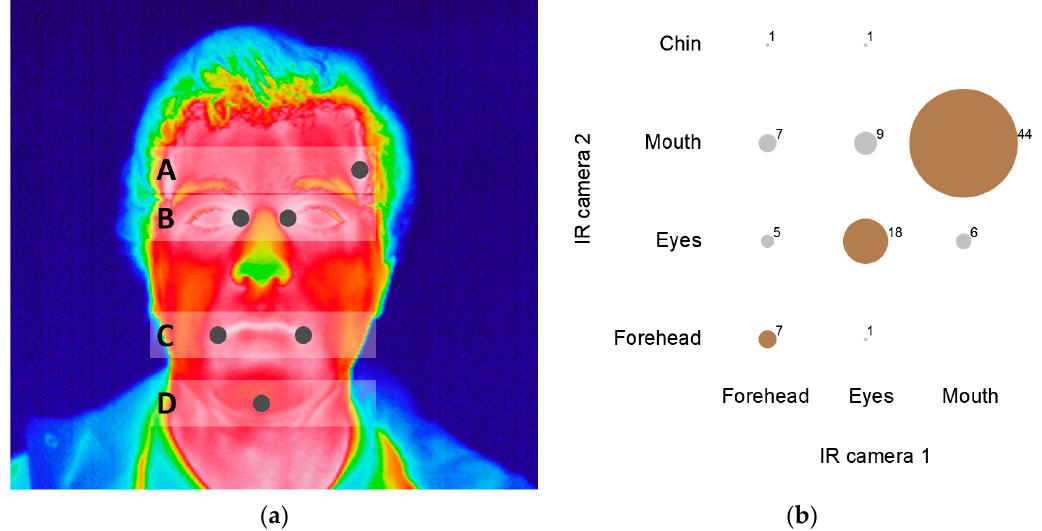
Figure 8. Locations of the hottest points in the face: ( a ) A—forehead; B—eyes; C—mouth; D—chin; ( b ) association between IR cameras. Table 2. Pearson’s correlation